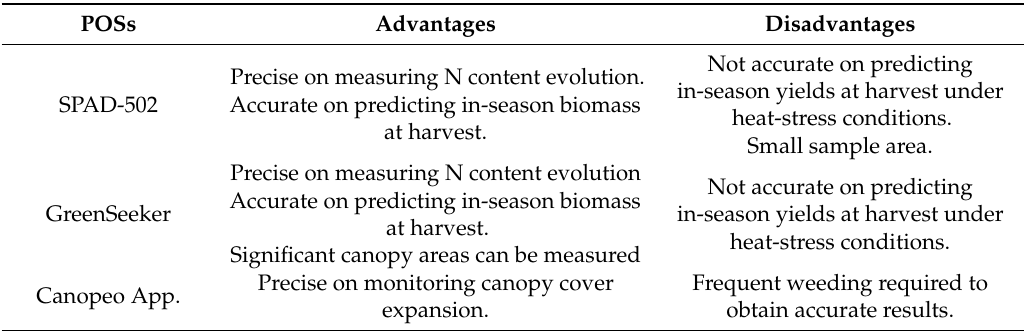
Table 5. Observed advantages and disadvantages of di ff erent Proximal Optical Sensors (POSs) on monitoring quinoa growth and